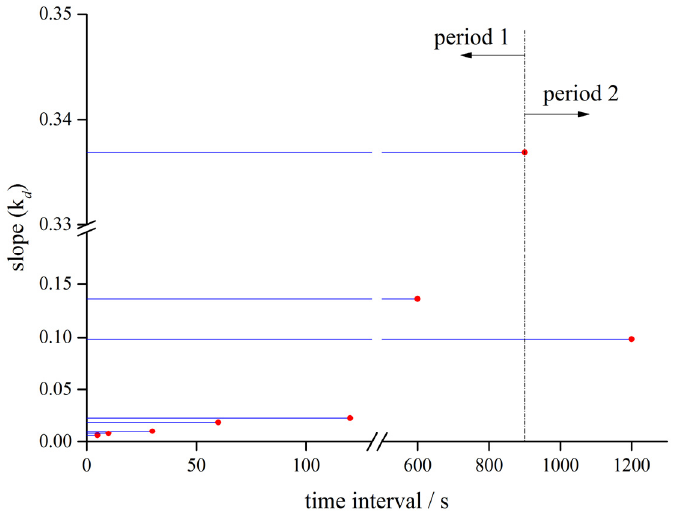
Figure 14. Relationship between the slope of the linear equation (k d ) and the time intervals during the stable damage